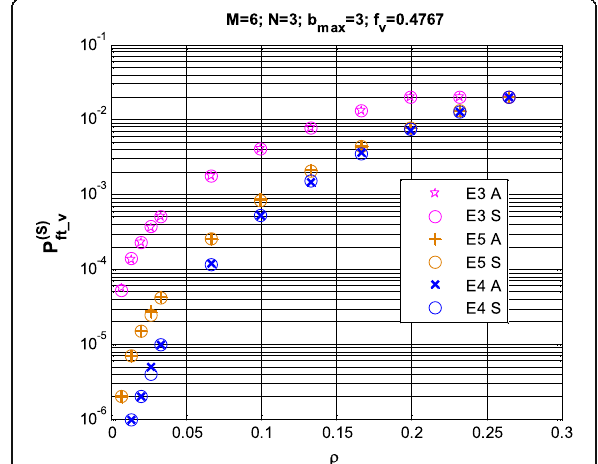
Fig. 11 Forced termination blocking probability of secondary voice users for the corresponding optimal configuration of each strategy as function of the primary channel utilization factor